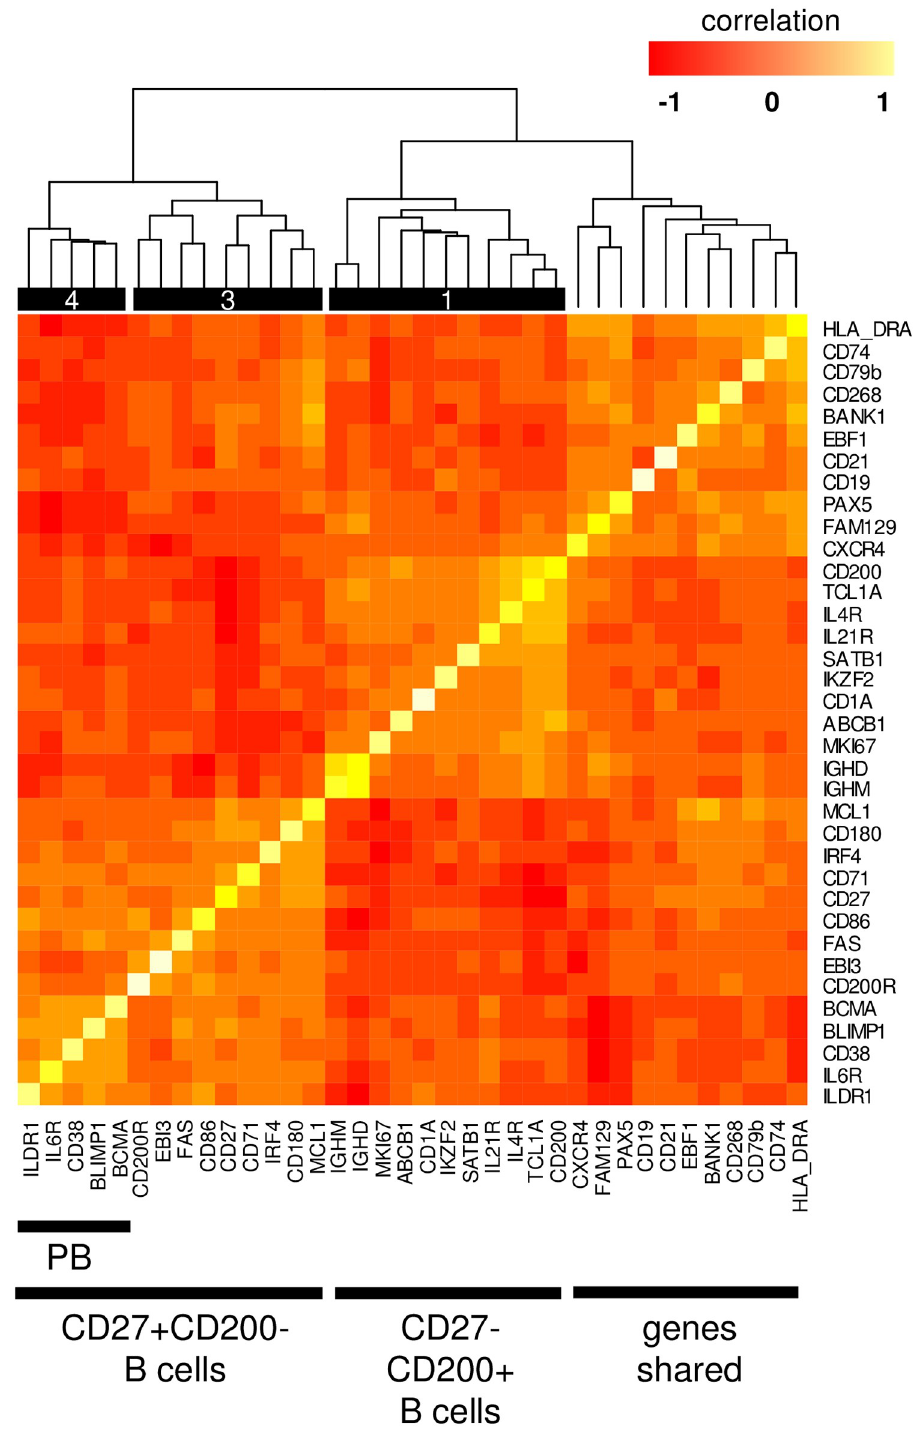
Fig 9. Hierarchically clustered correlation of gene expression from the pooled single cell data. The dataset contained all observations derived from all cells from two apheresis and two PBMC samples with the exception of cells that were negative of every sorting